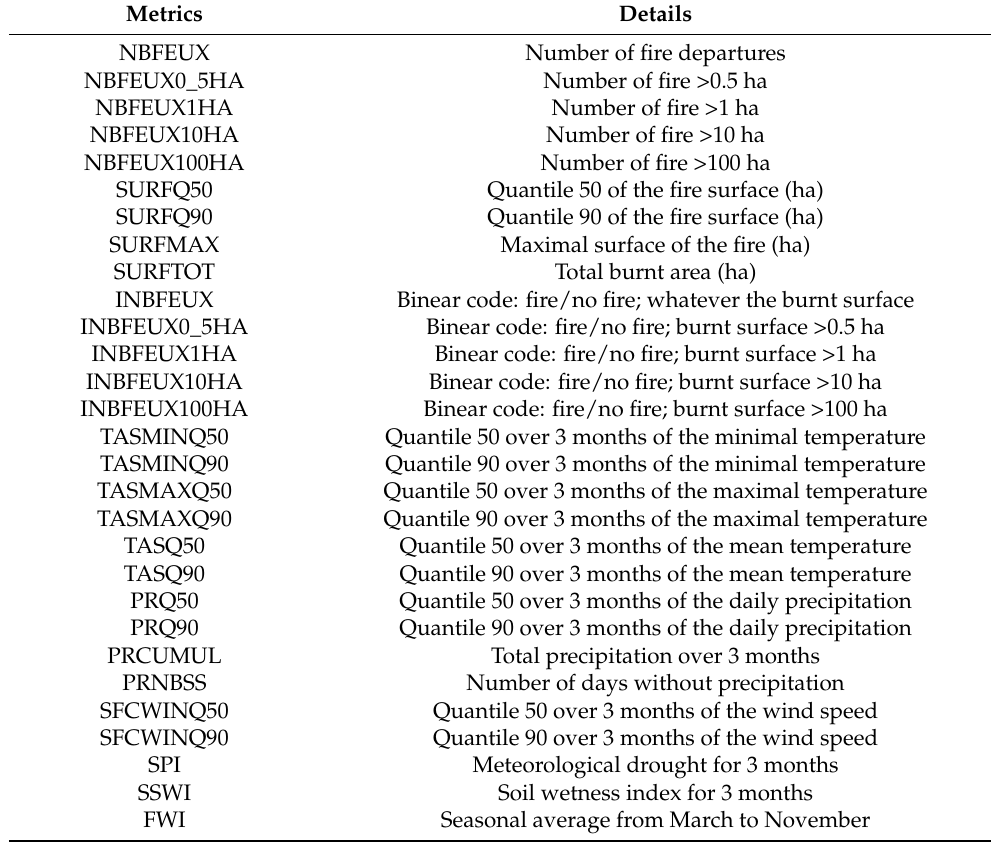
Table A1. Developedmetrics from theoverall databaseto beintegratedwithin themachine learning tools.